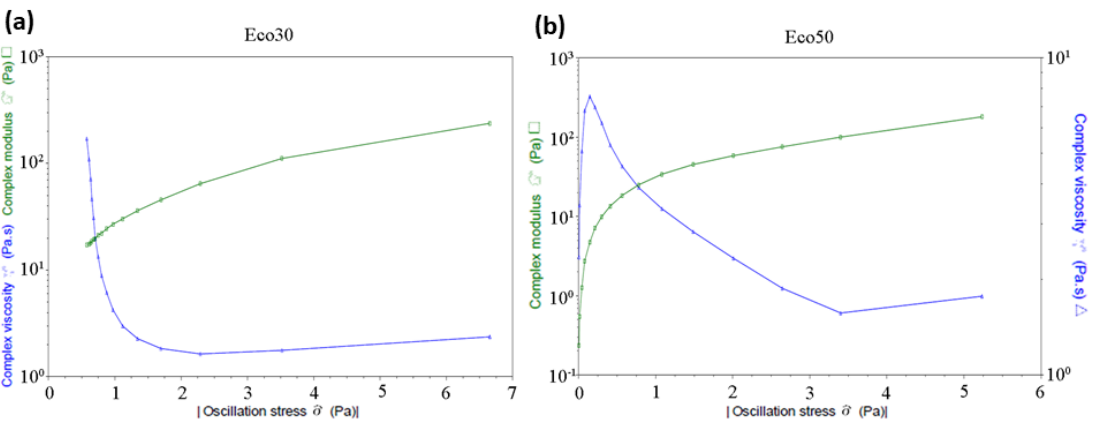
Figure 2. ( a ) Ecoflex30 and ( b ) Ecoflex50 complex viscosity and complex modulus versus shear stress. Figure 2. (a) Ecoflex30 and (b) Ecoflex50 complex viscosity and complex modulus versus shear stress.